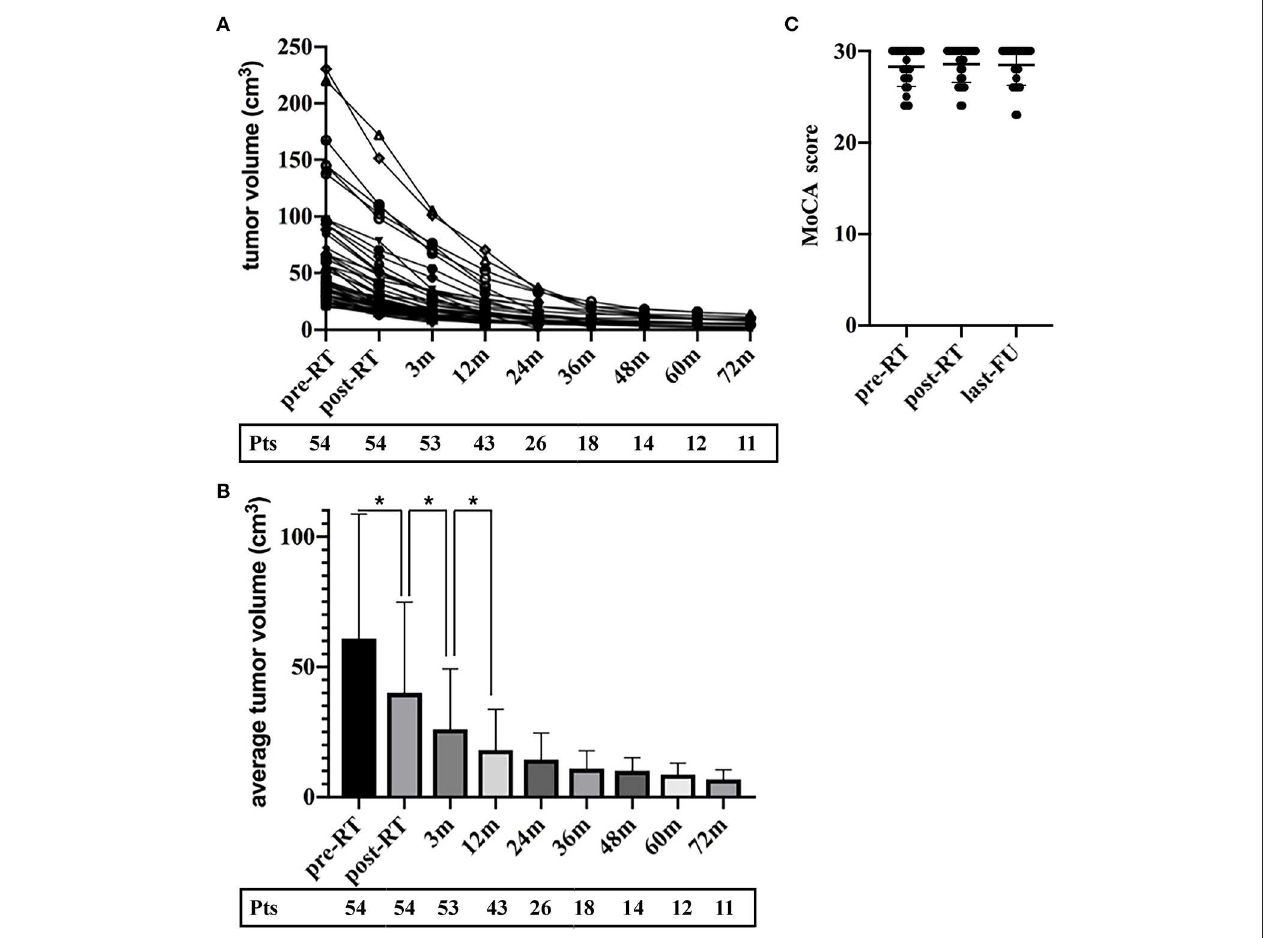
FIGURE 3 | The tumor volume reduced over the entire follow-up period without transient enlargement in all the patients. (A) The volume of the CSHs decreased in all patients. (B) The percentage of tumor volume during the follow-up intervals to their initial volume. (C) The MoCA score of participants at three-time points (pre-treatment, post-treatment and the last